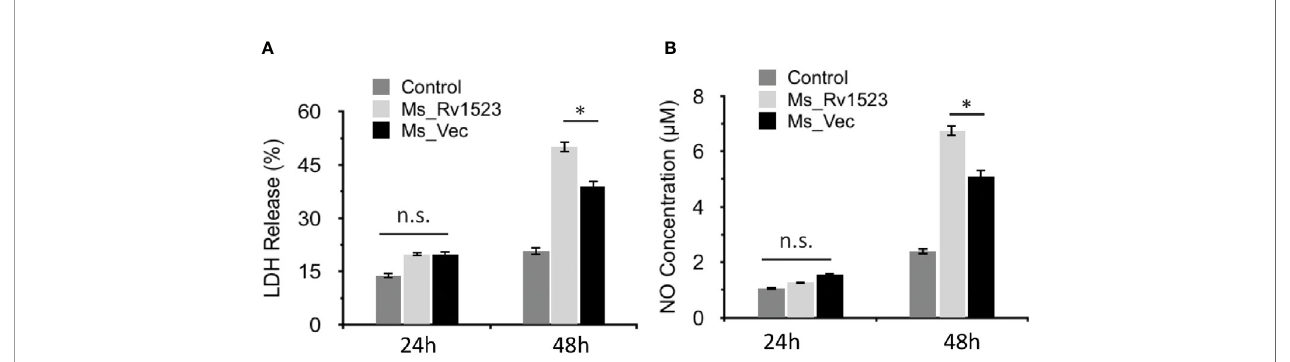
FIGURE 5 | Expression of M. tuberculosis Rv1523 in M. smegmatis promotes death of macrophages. (A) The release of LDH was observed to be more in Ms_Rv1523 infected macrophages; and similarly levels of NO released (B) were higher in the culture supernatants of Ms_Rv1523 infected macrophages as compared to the culture supernatants of Ms_Vec infected macrophages suggesting that Rv1523 expression induces and promotes necrotic cell death of the macrophages. Macrophages were infected with Ms_Rv1523 (white bars) or Ms_Vec (black bars) at an MOI of 10:1. No infection was used as control (gray bars). After 24 and 48 h infection, culture supernatants were collected and the levels of LDH released and the levels of NO released were measured. Data are shown as means ± SEM of triplicate wells. Kruskal – Wallis test was used for calculating statistical signi fi cance. ns, non-signi fi cant *p <